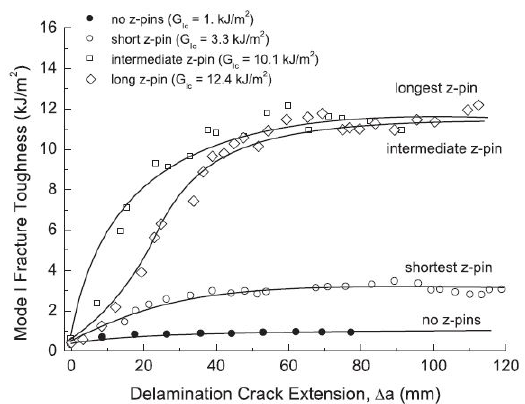
Figure 55. E ff ect of z-Pin embedment on mode I apparent fracture toughness of z-Pinned laminate (CFRP z-Pins, 2.0 vol%, d = 0.28 mm, [0 n [0 / 90] 2 ] s pre-preg)